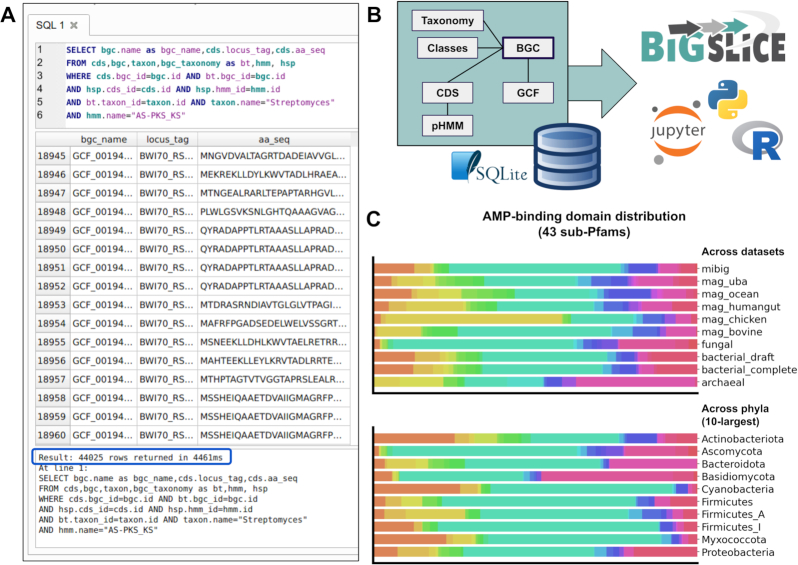

(A) An example SQL query for all protein sequences harboring ≥1 ketosynthase (AS-PKS_KS) domain from streptomycete BGCs. Here, the search performed against the total of ∼29 million coding sequences (CDSs) and >101 million domain hits in the database was completed in <5 seconds, returning 44,025 CDSs that satisfy the criteria. (B) A cartoon illustration on how the interconnected SQL tables holding various BGC-related information can be leveraged by downstream analyses, e.g., using programs and notebooks written in Python and R. (C) An example downstream analysis using the data on sub-Pfam hits to chart the diversity of AMP-binding domains across datasets and across phyla. Here, each colored bar represents the distribution of a specific sub-Pfam clade across the sampled dataset/phylum. Each analysis including the SQL query took ∼55 seconds to complete. A script to perform such analyses (which can also be used to investigate other biosynthetic domains) and generate the plots can be found in the “figure_4” folder of the Supplementary Dataset [123].